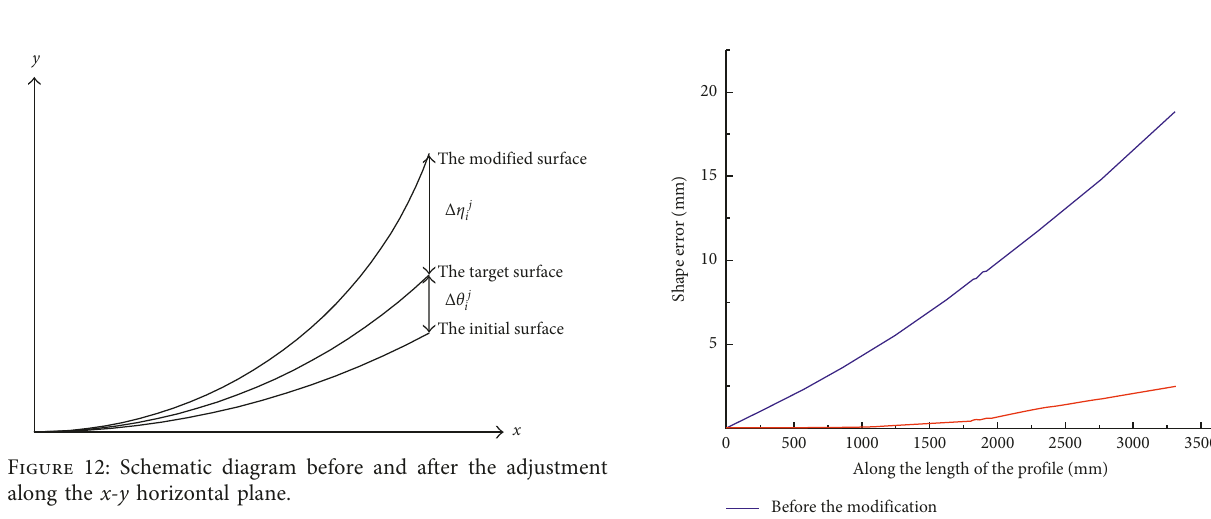
Figure 11: The springback value along the longitudinal direction of the profile. (a) The springback value along the x - y plane. (b) The springback value along the x - z plane.